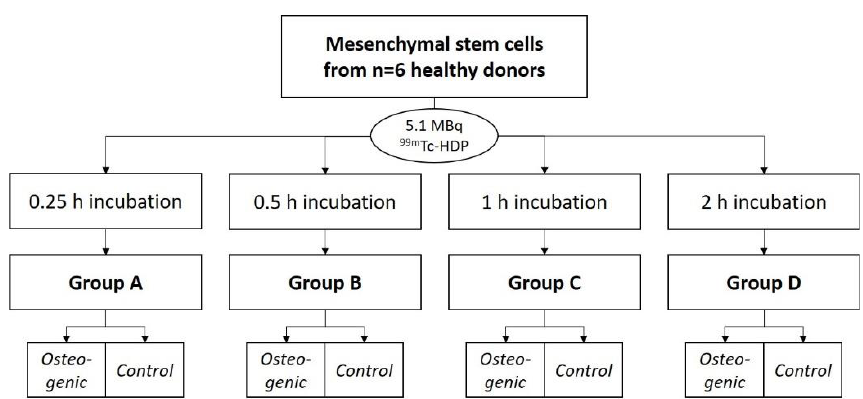
Figure 9. Study design for the 99m Tc-HDP saturation time evaluation.